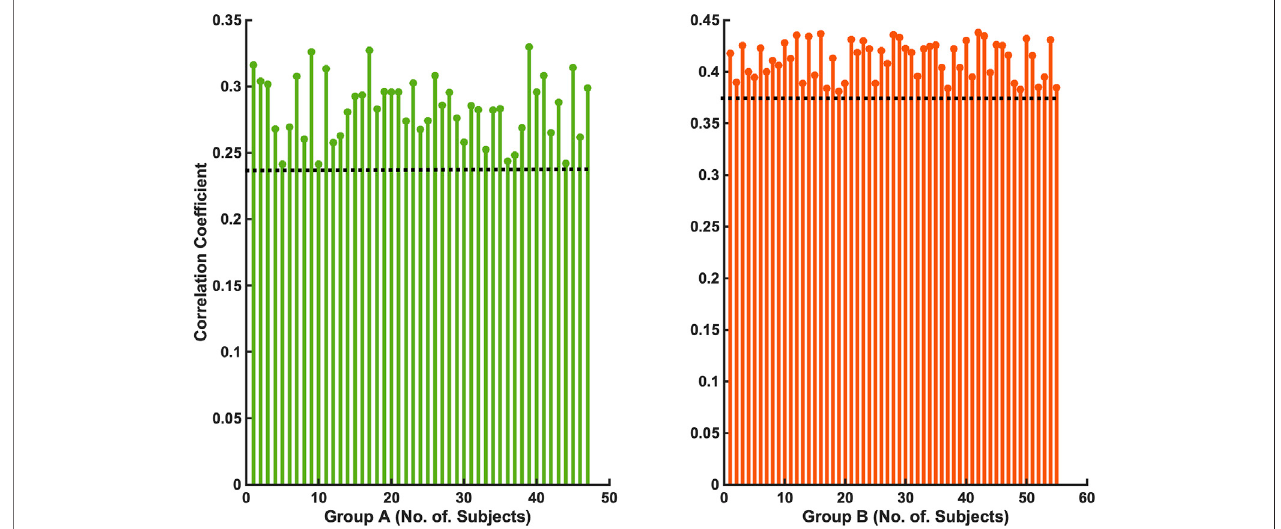
FIGURE5| Showsthecorrelationcoef fi cientbetweenthearousal-AUCandSpO2-AUCforallarousalsofeveryindividualofthetwoseparategroups(GroupA:AHI 15 – 30/h of TST; Group B: AHI > 30/h of TST).